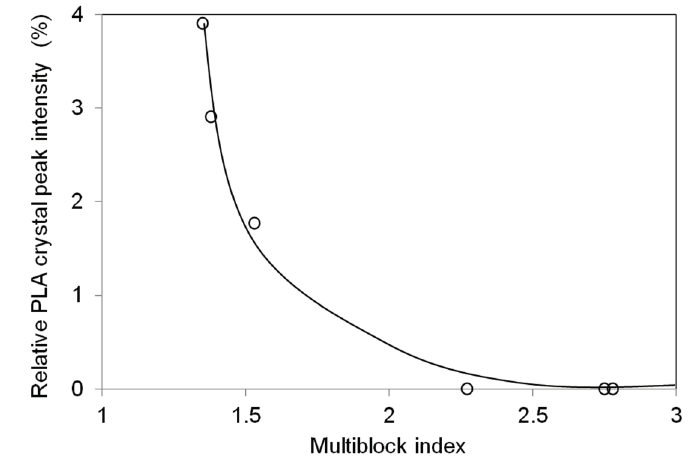
Figure 9. Relative PLA crystal peak intensity in the micelle of PLA–PEG multiblock copolymers as a function of multiblock